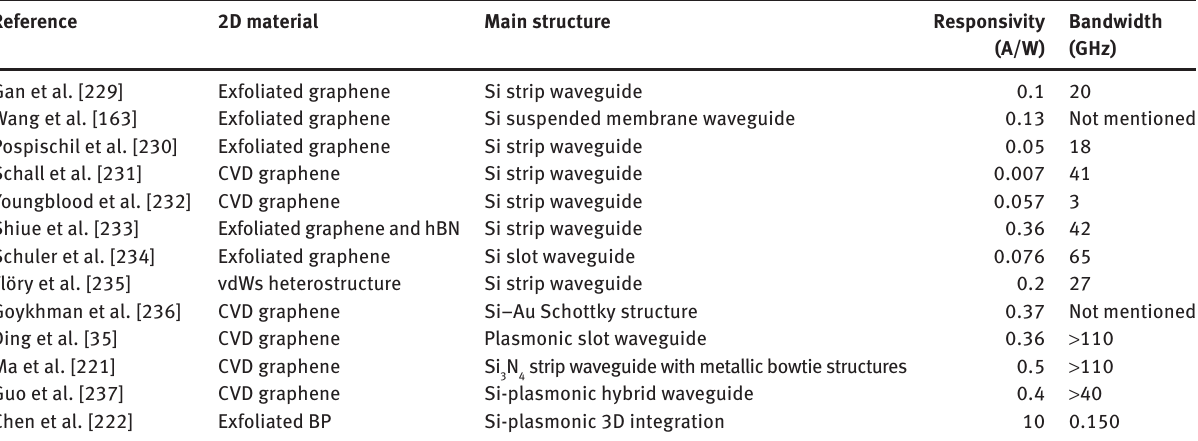
Table 1: Summary of waveguide-type photodetectors using different waveguide and 2D